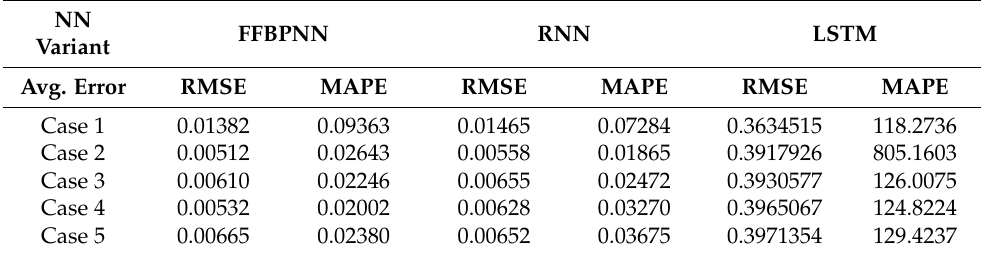
Table 10. Testing results of FFBPNN, RNN, and LSTM for all